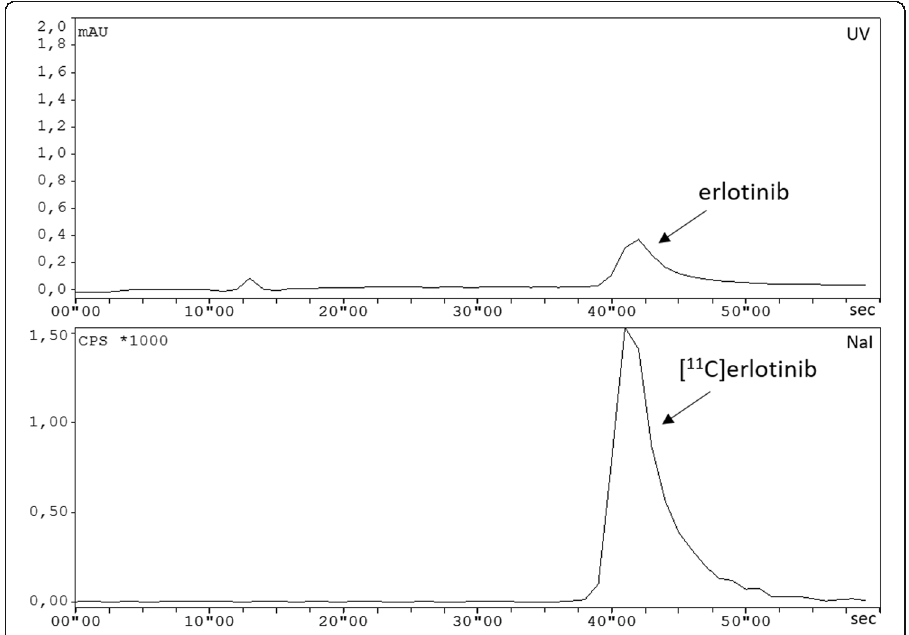
Fig. 4 Typical chromatogram of the purified and formulated [ 11 C]erlotinib using the optimized analytical HPLC (top: UV-channel; bottom: